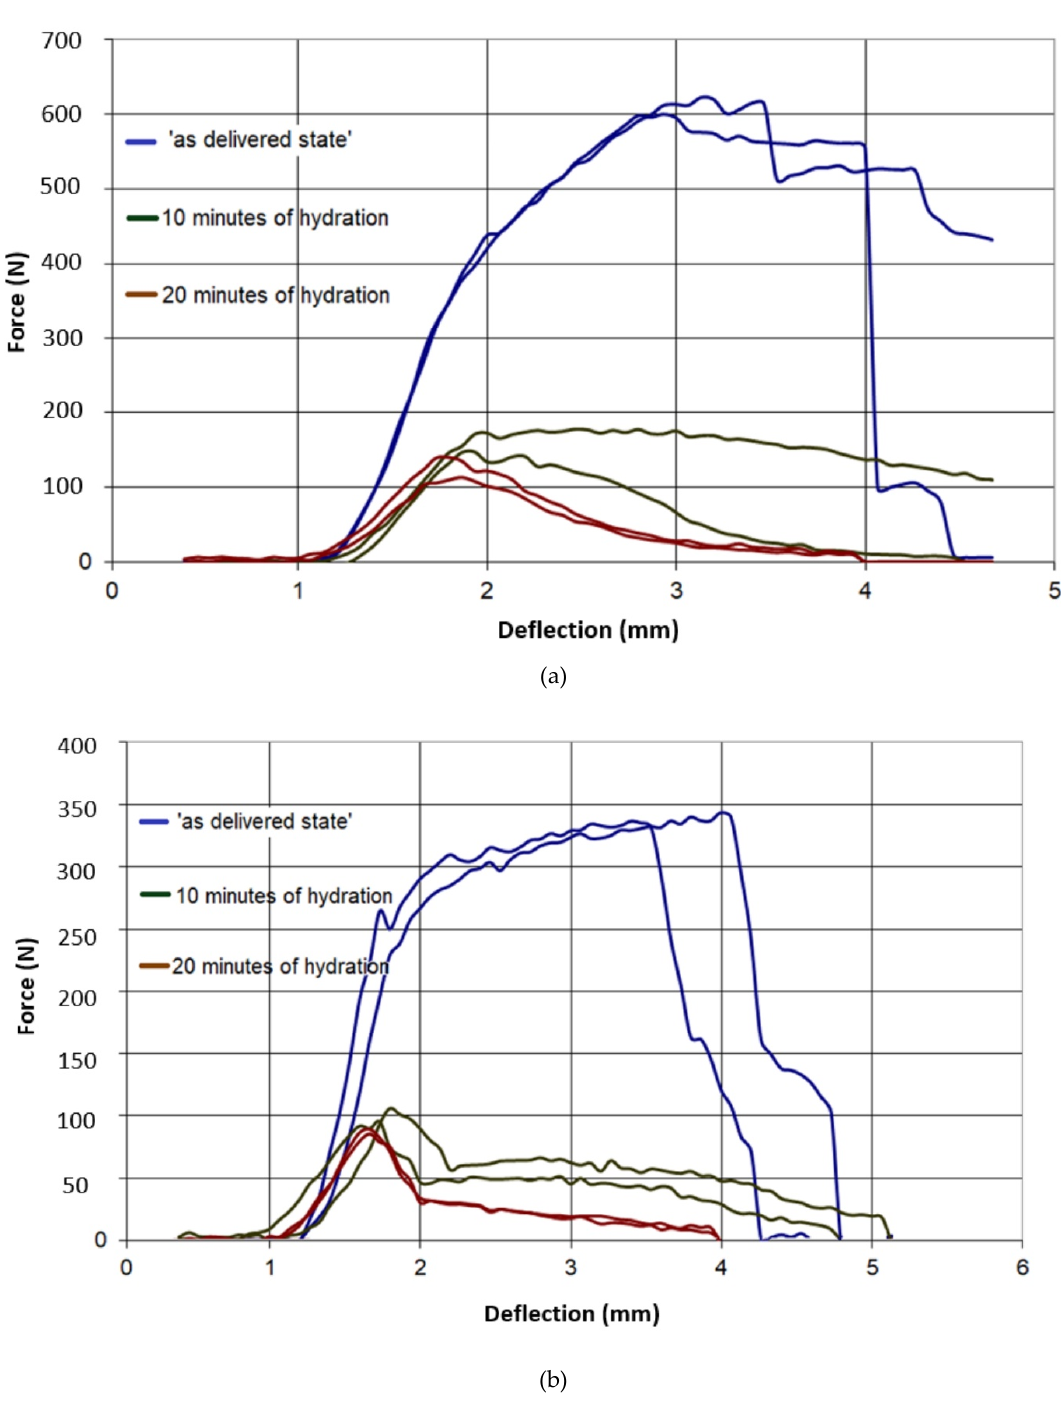
Figure 11. Force–deflection curves of the tested specimens of type K, ( a ) parallel to the sheet production direction, ( b ) perpendicular to sheet production direction.